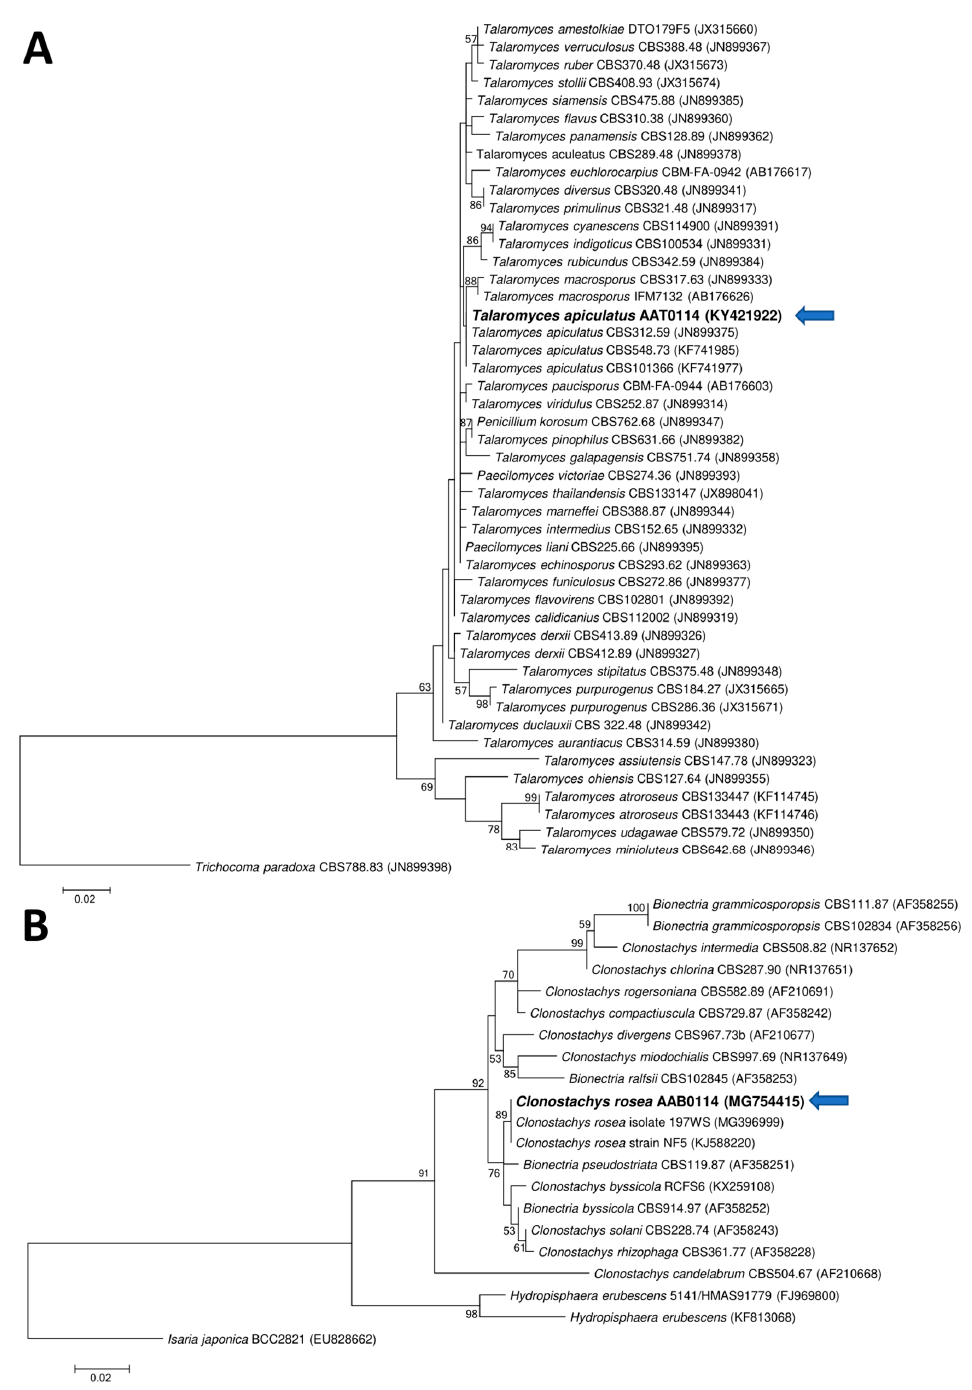
Figure 2. Phylogenetic relationship of ( A ) AAT0115 or ( B ) AAB0114 and their closely related isolates / species based on the internal transcribed spacer (ITS) rDNA sequences and positions of currently studied ascomycetes (in bold) (arrow). Two fungal taxa—namely Trichocoma paradoxa CBS788.83 (JN899398) and Isaria japonica BCC2821 (EU828662)—were used as the outgroups for the respective phylogenetic trees generated through maximum likelihood approach. Bootstrap values of ≥ 50% from 1000 bootstrap repetitions are shown for the corresponding branches. Scale bars indicate estimation of 0.02 substitutions per nucleotide position for the branch lengths.